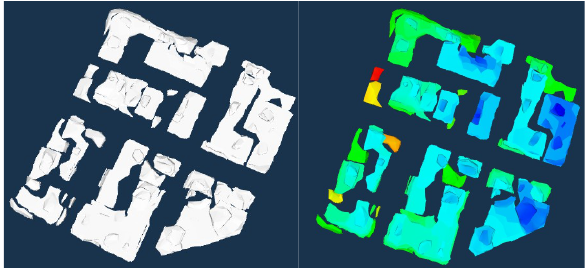
Figure 9. The result of the proposed 3D reconstruction methodology (left) and the height colorized representation (right)